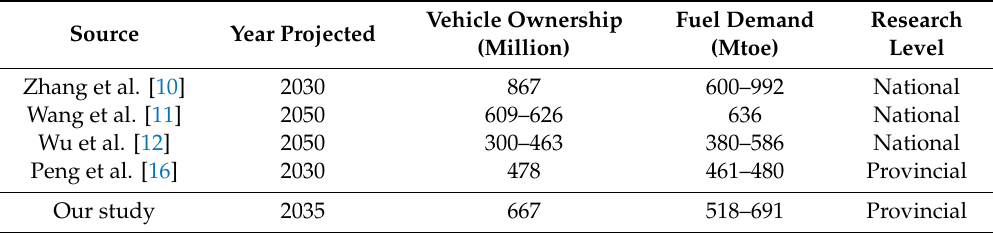
Figure 7. Provincial projections of gasoline and diesel consumption in 2035. Table 6. Comparisons of projections of the fuel demand in China.